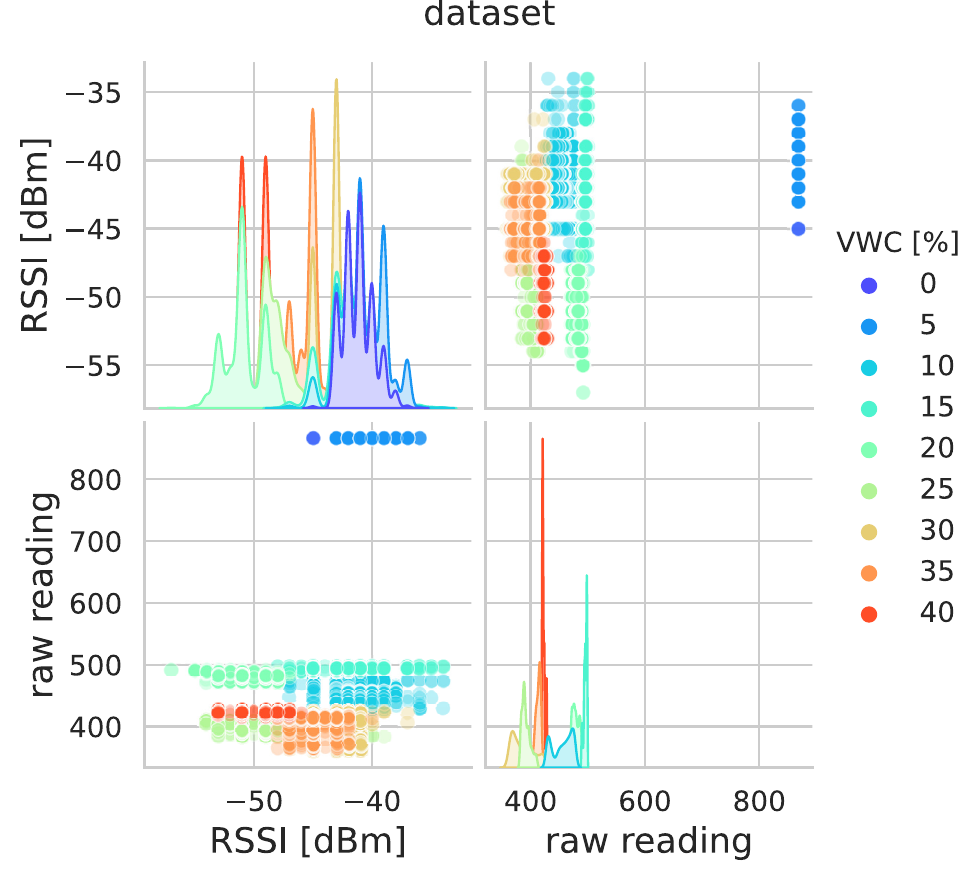
Figure 8. Scatterplots of collected data, showing pair relationships between raw sensor readings and RSSIs. Each pairwise data point is highlighted using a colour code depending on the values of the reference VWC: dark blue represents 0% VWC, up to red representing 40% VWC. Along the diagonal, smoothed histograms using a standard kernel method of the corresponding variable are